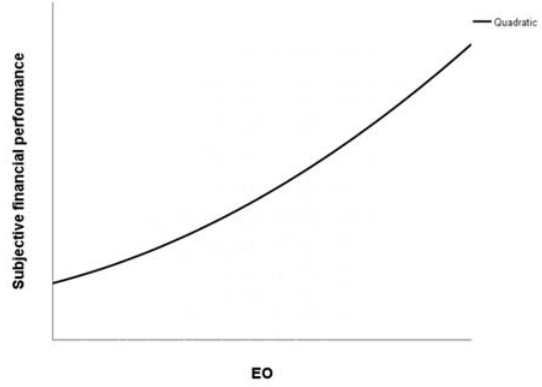
Figure 1. Nonlinear effect of EO on financial firm performance.